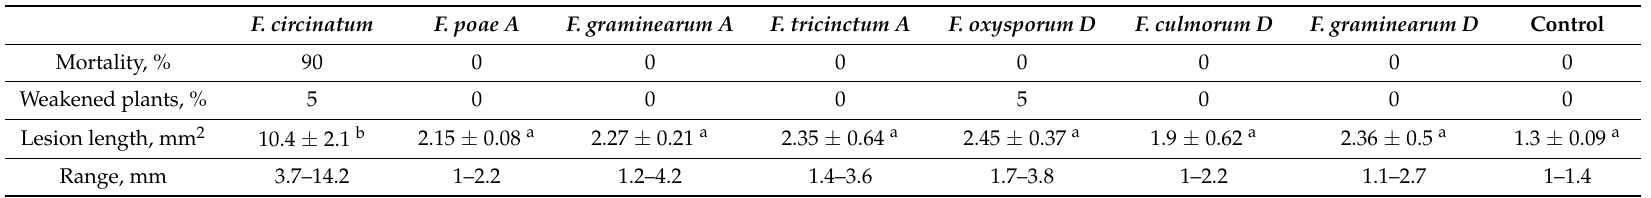
Table 4. Level of mortality and lesion length (mm) in one-year-old P. sylvestris seedlings inoculated with different species of Fusarium